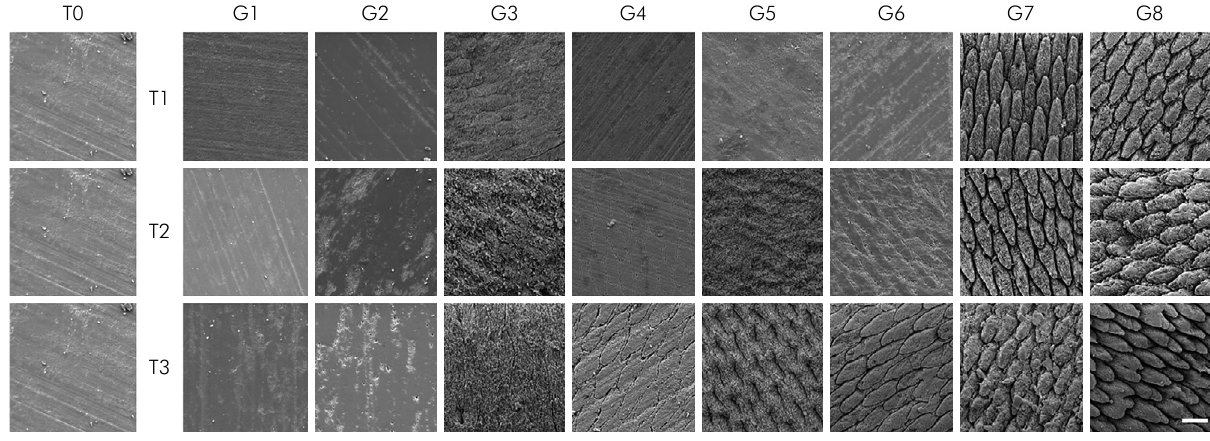
Figure. SEM micrographs depicting the different treatments as a function of time. Columns indicate the following groups: G1, AS; G2, toothbrushing; G3, orange juice; G4, 10% carbamide peroxide; G5, orange juice + toothbrushing; G5, 10% carbamide peroxide + toothbrushing; G6, 10% carbamide peroxide + toothbrushing; G7, 10% carbamide peroxide + orange juice; and G8, 10% carbamide peroxide + orange juice + toothbrushing. Lines indicate the following times: T0 (no treatment), T1 (14 days, positive control), T2 (21 days), and T3 (28 days). Scale bar: 5